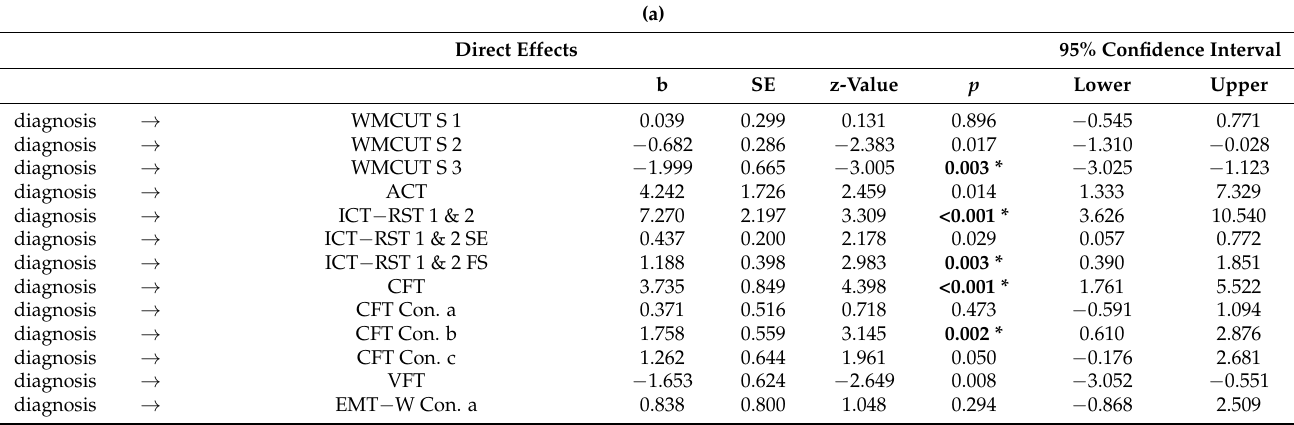
Table 2. ( a ) Direct effects of diagnosis on the R4Alz-R tasks’ and subtasks’ performance according to Mediation Analysis, between the groups of SCD and HC ( * p < 0.004). ( b ) Indirect effects of diagnosis—via age and education—on the R4Alz-R tasks’ and subtasks’ performance according to Mediation Analysis, between the groups of HC and SCD (* p <